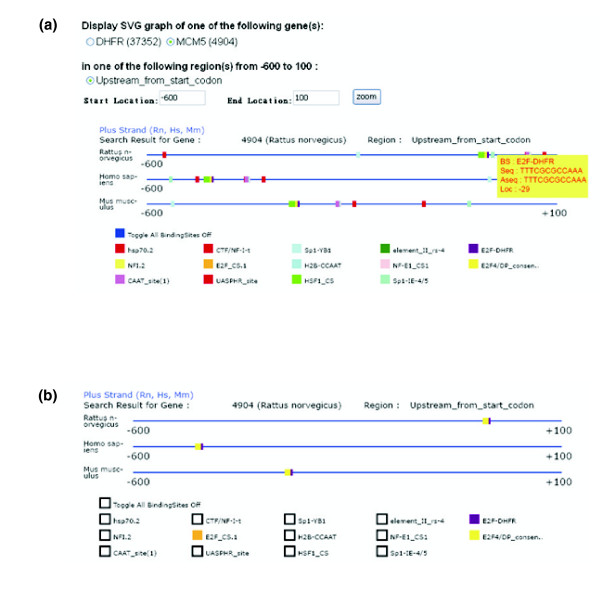
Graphic display of transcription binding sites in the MCM5 promoter region. (a) Visualization of the MCM5 upstream region. MCM5 upstream region (-600 to +100 base pairs) is shown, where +1 is the transcription start site. Only binding site sequences that go across genomes are shown. (b) The same region as is shown in panel a, with only the E2F sites highlighted.